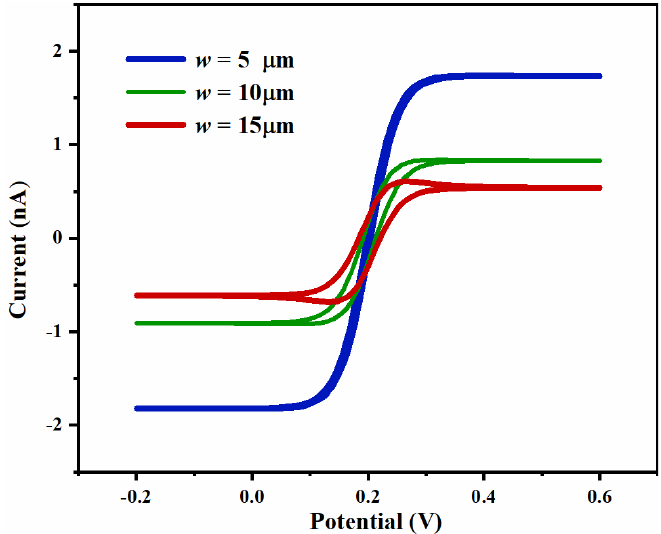
Figure 6. Simulated CV curves of UIAE with different electrode widths.